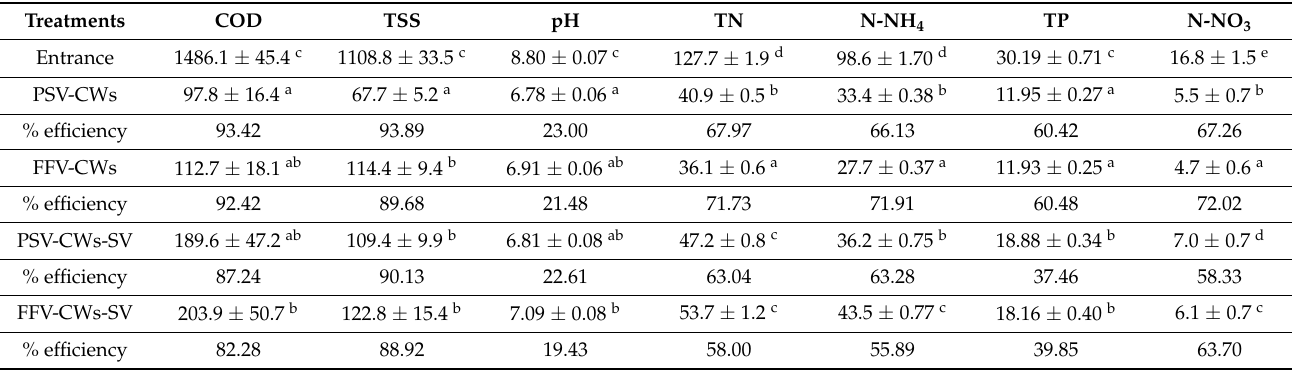
Table 2. Statistical difference (Kruskal–Wallis with p = 0.0001) and removal efficiencies in each of the treatments during the study